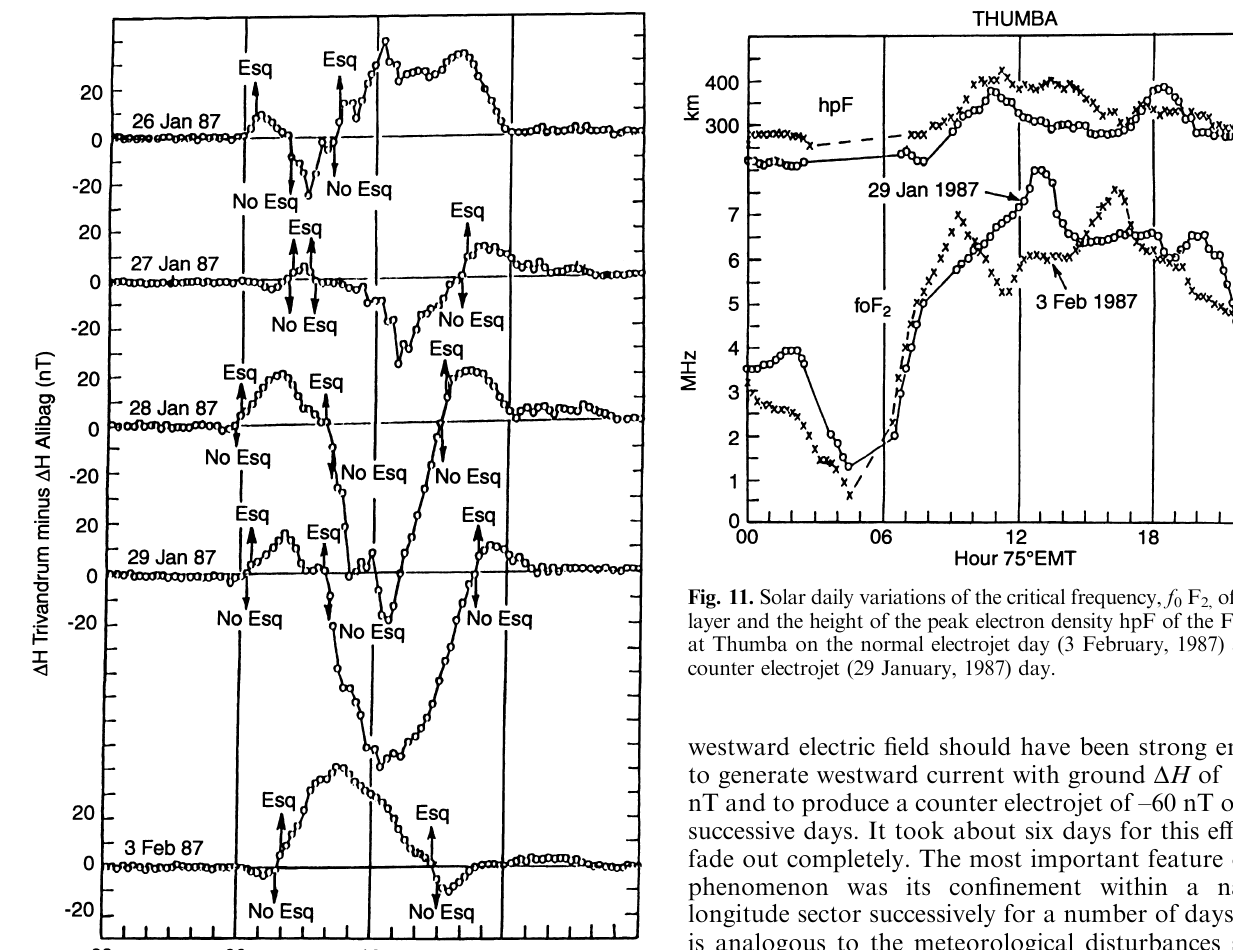
F of the F 0 2, 2